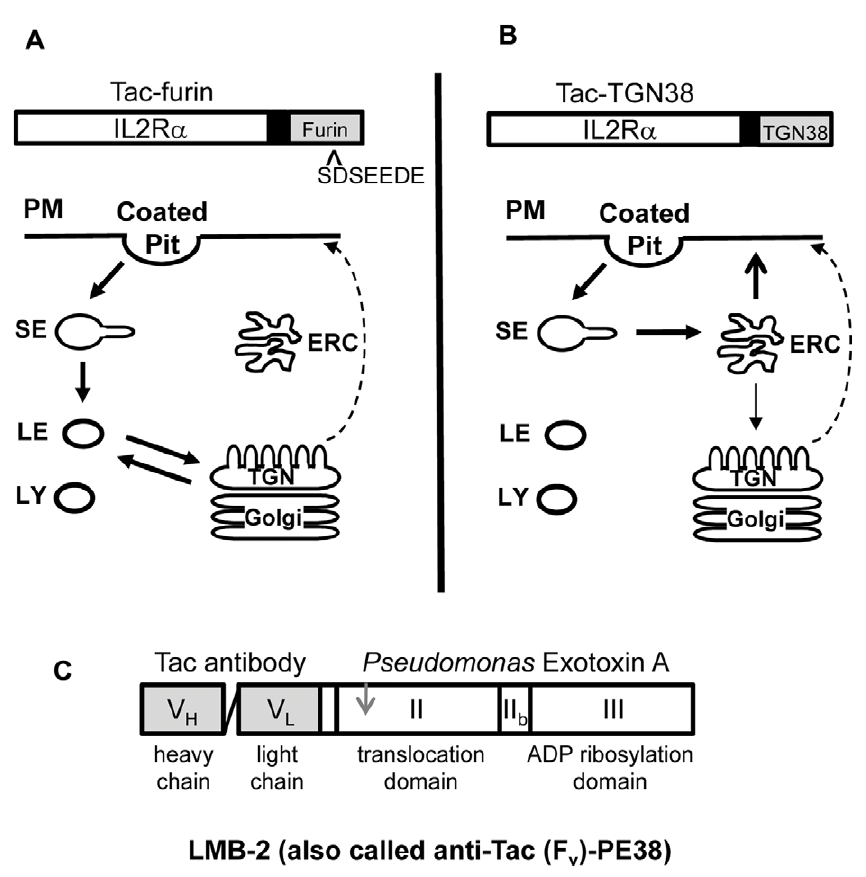
Figure 1. Transport pathways taken by Tac chimeras. Tac-furin ( A ) and Tac-TGN38 ( B ) are internalized from the plasma membrane (PM) and transported to the sorting endosome (SE). From here, Tac-TGN38 passes through the endocytic recycling compartment (ERC). Most of the Tac-TGN38 returns to the PM, but about 20% of the molecules in the endocytic recycling compartment are trafficked to the trans Golgi network (TGN). In contrast, Tac-furin passes through maturing endosomes on its way to the TGN without accumulating to any observable degree in the endocytic recycling compartment. Dashed line indicates anterograde transport from TGN to PM. Above each panel are diagrams of the Tac chimeras showing the Tac lumenal (white) and transmembrane (black) domains, and the cytoplasmic tail domain of furin or TGN38 (gray), respectively. C ) Stick representation of LMB-2 indicating the various domains of the immunotoxin. The variable domain (heavy and light chain) of the Tac antibody (gray) are linked with a small peptide linker. The truncated version of Pseudomonas exotoxin A (white) consists of the translocation domain (II) and the enzymatic domain (III), but lacks the wild type binding domain. The gray arrow indicates an essential proteolytic processing site after amino acid 279.